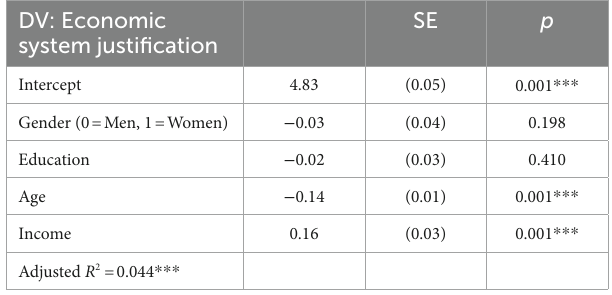
TABLE 4 Results of multiple regression analysis (DV: